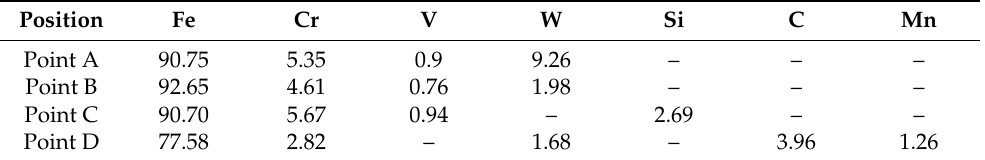
Table 4. EDS results of each position (atomic fraction).